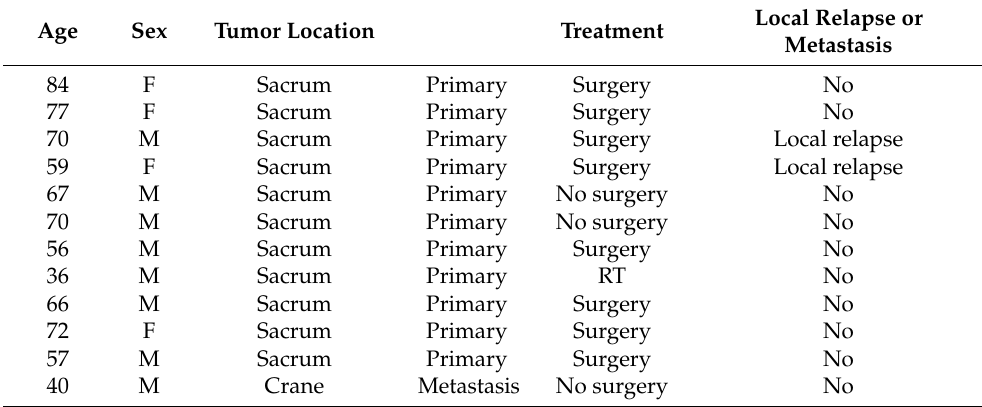
Table 1. Patients clinical